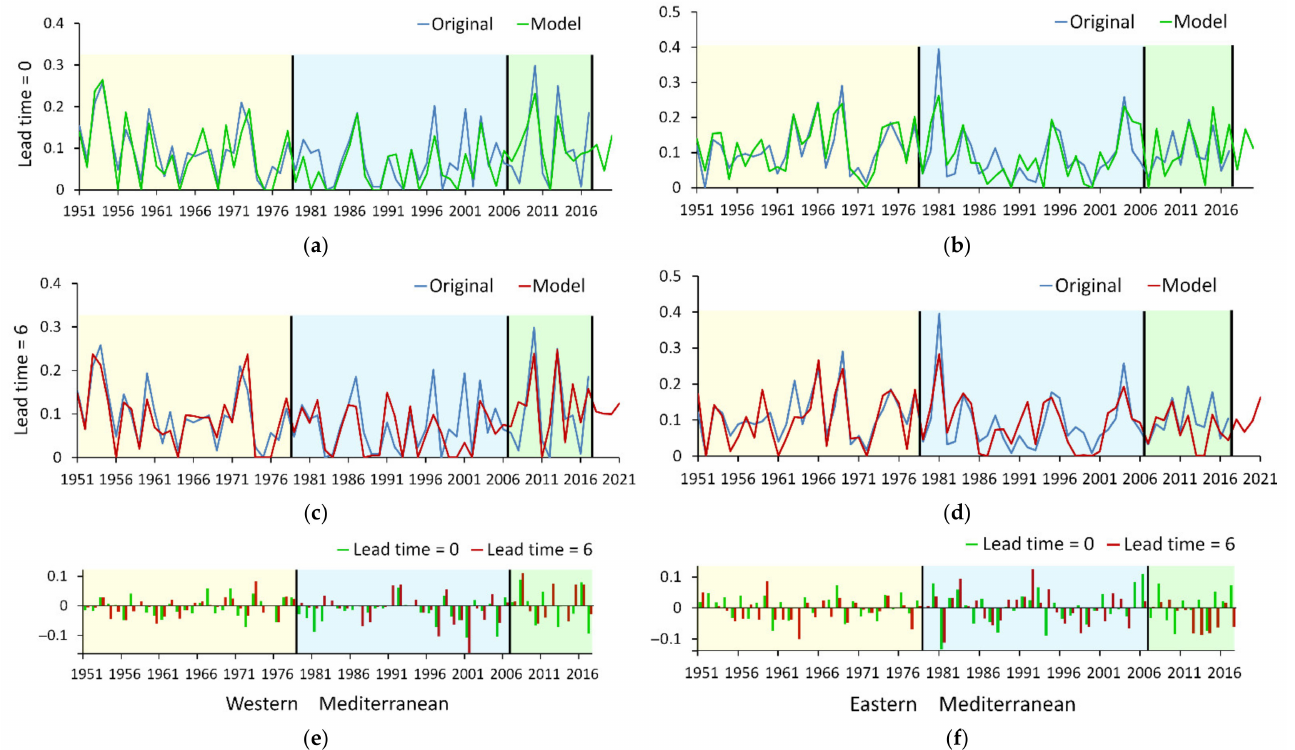
Figure 11. The frequency of intense cyclones in January: initial values (original) and model simulations (model) over the Western ( a , c ) and Eastern ( b , d ) Mediterranean for the two variations of the model: without the possibility of an advance forecast (lead time = 0) ( a , b ) and with the possibility of a forecast 6 months in advance (lead time = 6) ( c , d ). Vertical black lines mark the range of the training sample (1951–1978), test sample (1979–2006), control sample (2007–2017), and modeling period without the initial values of cyclones (2018–2021). Below, there are absolute error diagrams of the synchronous model (green bars) and the model with a lead time of 6 months (red bars) for the Western ( e ) and Eastern ( f )